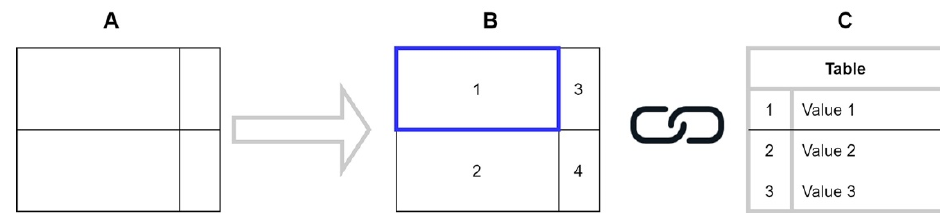
Figure 4. Base element extraction schema: A – vector wireframe; B – identification of base element on wireframe and assign ID; C – joining base element with table in database by ID field.